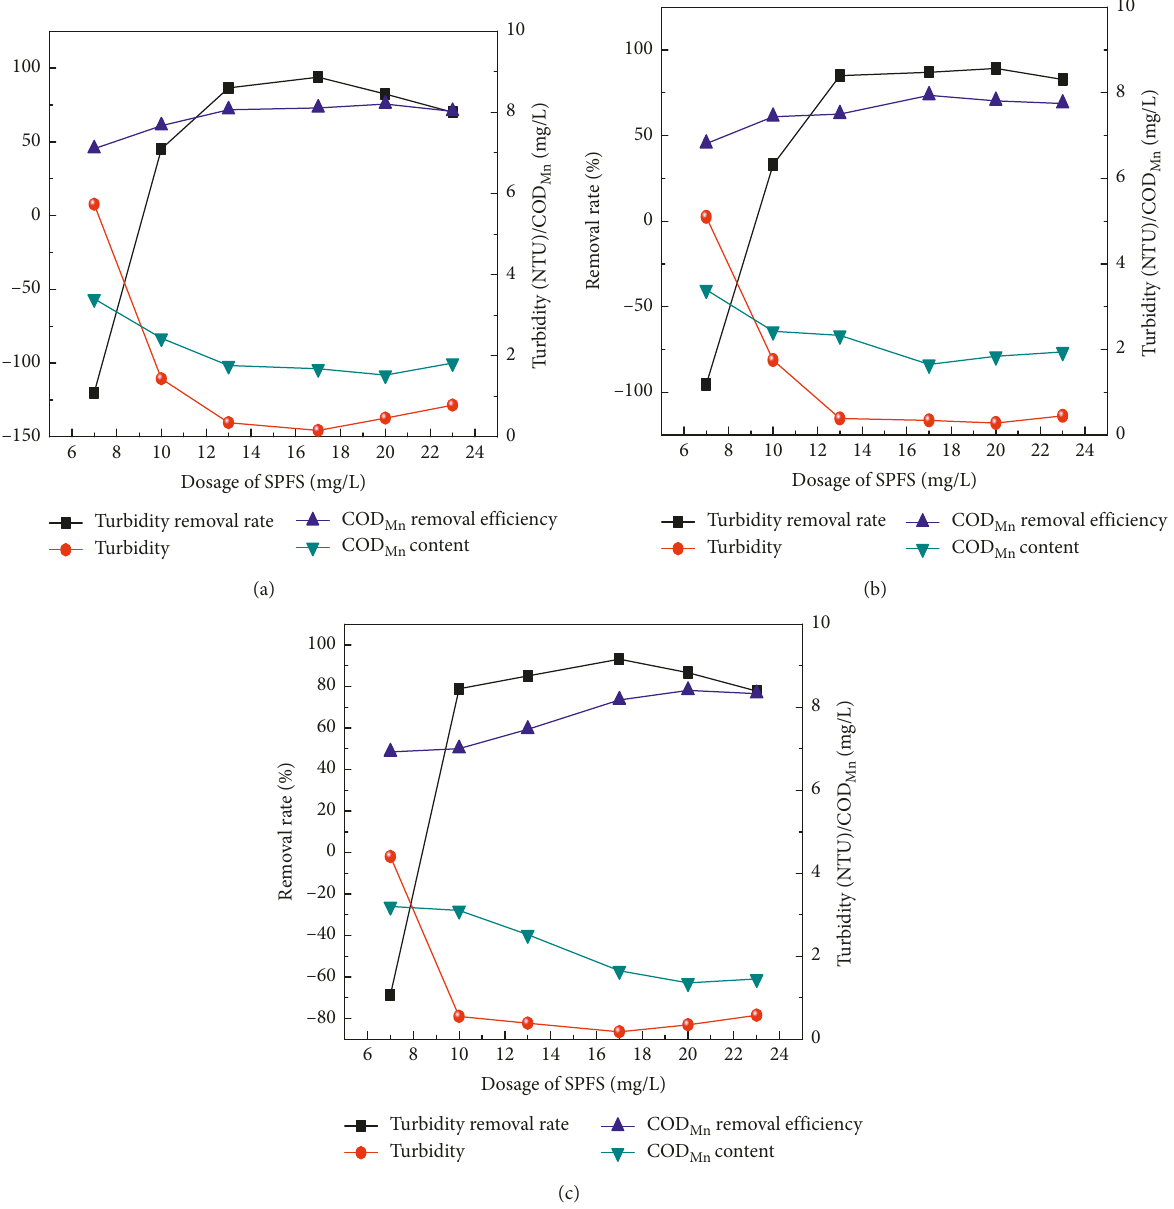
3 SPFS; (b) 60kg/m 3 SPFS; (c) 80kg/m 3 Mn removal efficiency: (a) 40kg/m